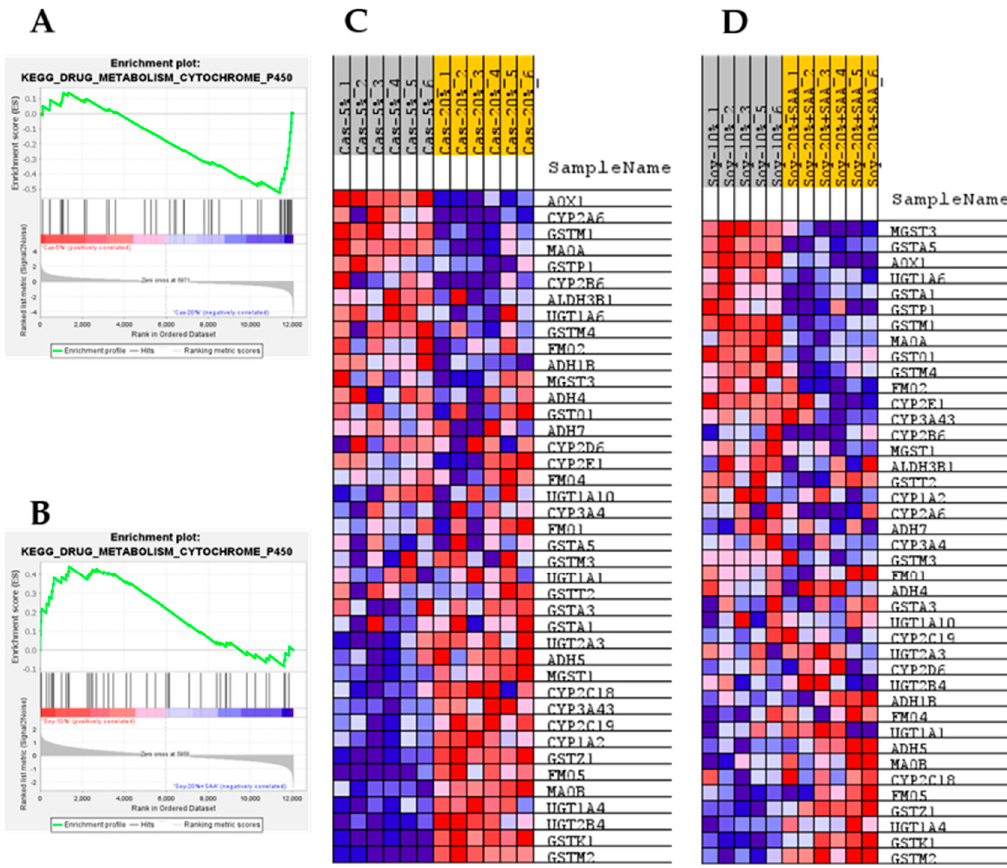
Figure 5. Gene set enrichment analysis (GSEA) of hepatic gene expression in mice fed sulfur amino acid-matched control diets formulated from casein (Cas-20%) or soy (Soy-20% + SAA), and sulfur amino acid-matched protein restricted diets formulated from casein (Cas-5%) or soy (Soy-10%). The enrichment plots and corresponding heat maps are shown for the KEGG Drug Metabolism Cytochrome P450 gene set for the Cas-5% to Cas-20% ( A , C ) and Soy-10% to Soy-20% + SAA comparisons ( B , D ). Enrichment was computed as described in the Material and Methods, and enrichment plots were generated to visualize the individual contributions of pathway genes to pathway enrichment. Accompanying heat maps present the normalized enrichment scores for individual genes within the gene set [blue = downregulation, red = upregu- lation, gray = not significant (FDR > 0.1)].